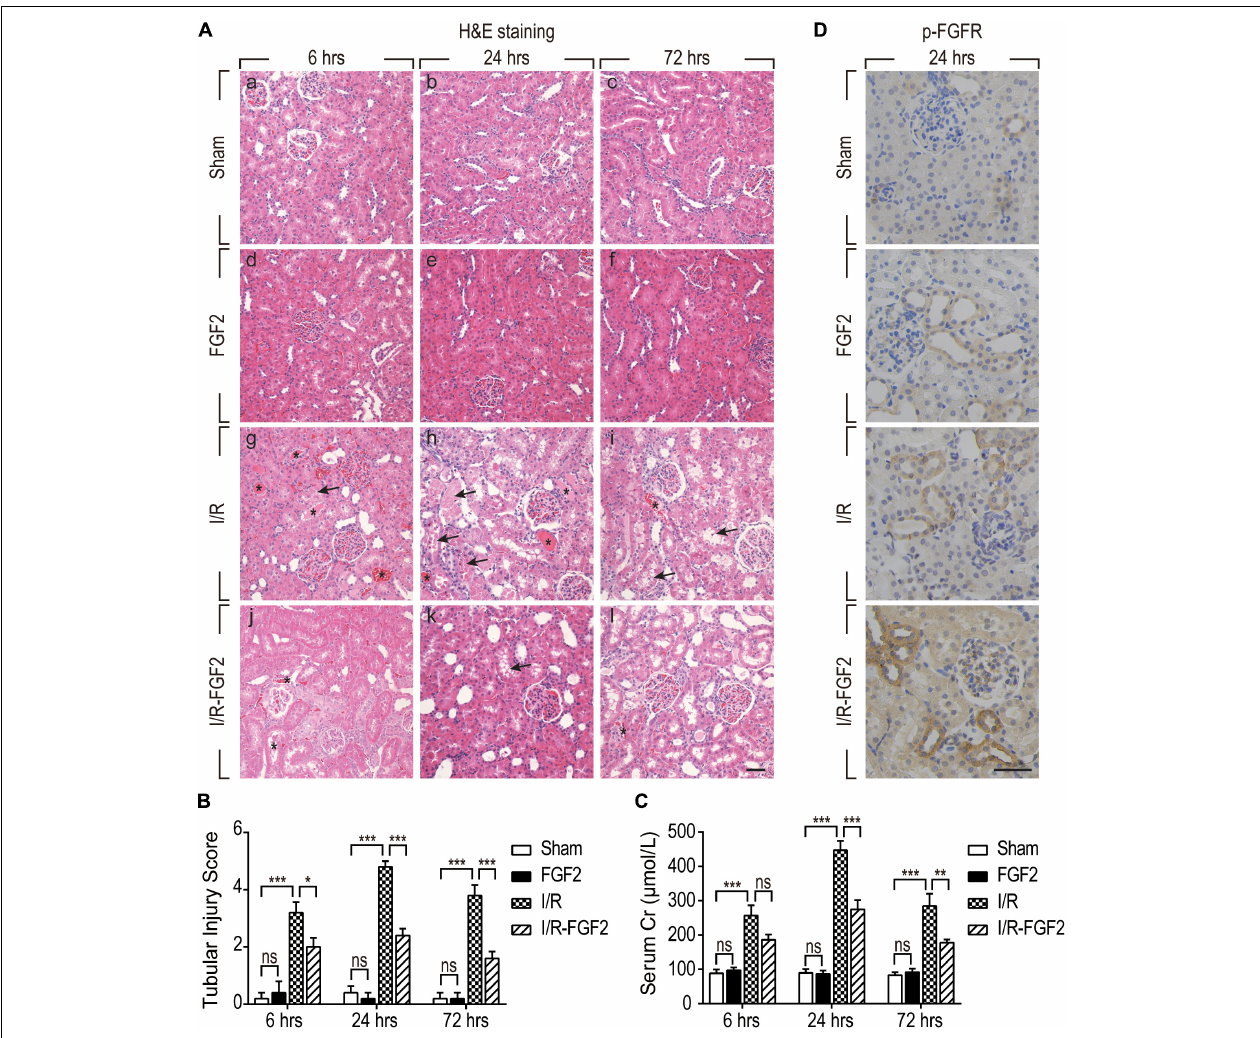
FIGURE 1 | Fibroblast growth factor 2 protects kidney against renal I/R injury via the activation of FGFR. (A) Renal histological evaluations were assessed with H&E staining at 6, 24, and 72 h after reperfusion. Asterisks show interstitial congestion, edema, and proteinaceous casts. Arrows represent intraluminal necrotic cellular debris. Images are representative of five animals in each group. Scale bar represents 50 µ m. (B) Renal tubular injury scores were quantified and analyzed based on H&E staining. Results are representative of five animals in each group. (C) Serum creatinine levels of rats from the Sham, FGF2, I/R, and I/R-FGF2 groups at 6, 24, and 72 h after reperfusion. Representative data of five individual samples in each group. (D) Immunohistochemistry staining for phosphor-FGFR at 24 h after reperfusion. Images are representative of five animals in each group. Scale bar represents 50 µ m. * P < 0.05, ** P < 0.01, *** P < 0.001; ns indicates not statistically